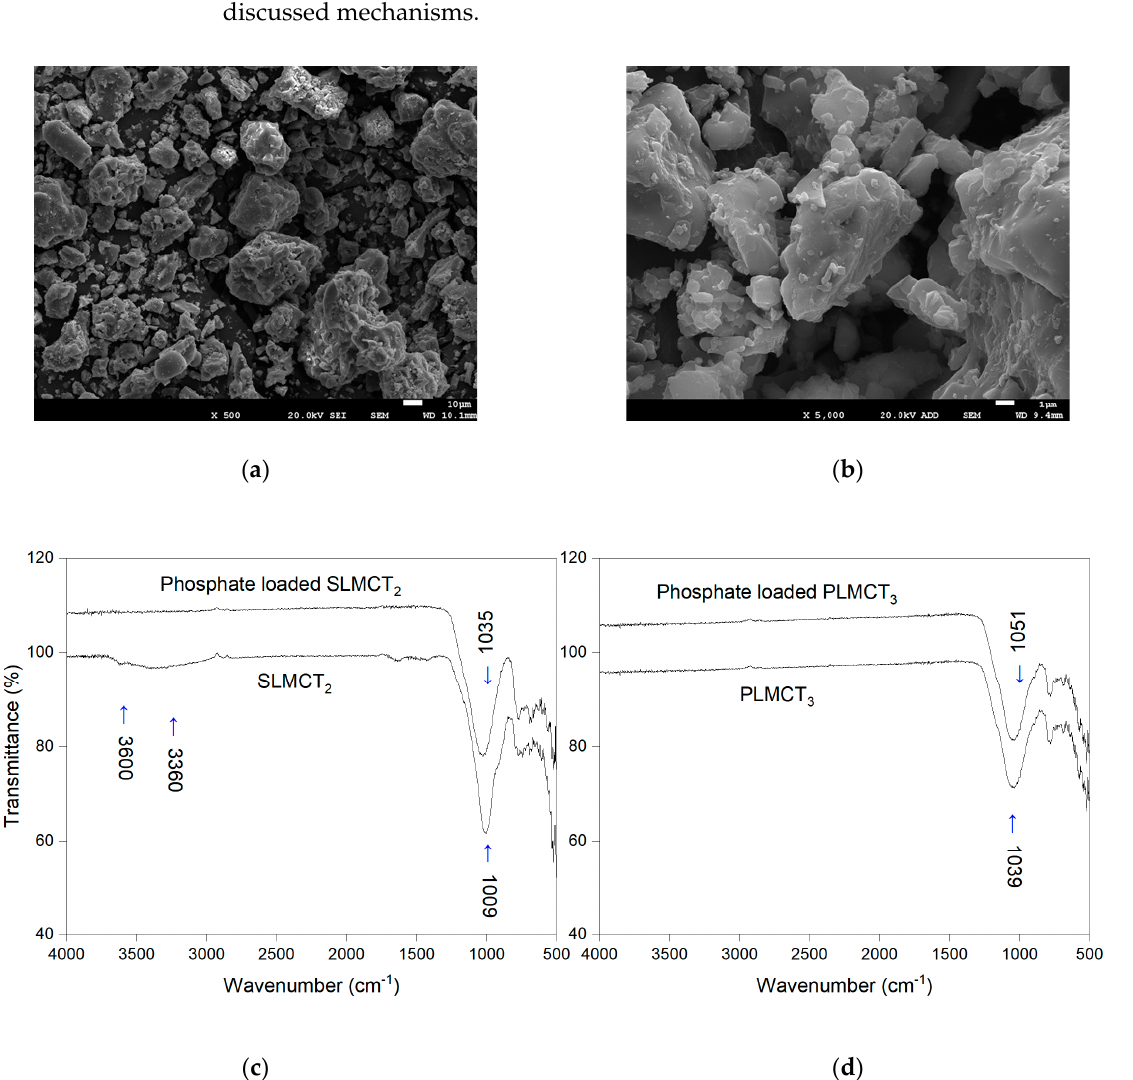
Figure 8. SEM photography of the adsorbents after phosphate adsorption: ( a ) pellets muscovite/analcime composites PLMCT 3 , ( b ) monolith muscovite/analcime SLMCT 2 and comparison of FTIR spectra between composites before and after phosphate adsorption: ( c ) monolith muscovite/analcime (SLMCT 2 ) and ( d ) pellets muscovite/analcime composites (PLMCT 3 ).